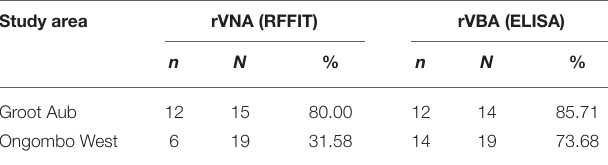
TABLE 3 | Seroconversion rate of dogs after oral [bait and direct oral administration (d.o.a.)] vaccination according to RFFIT ( > 0.5 IU/ml) and ELISA ( > 40% PB) according to study